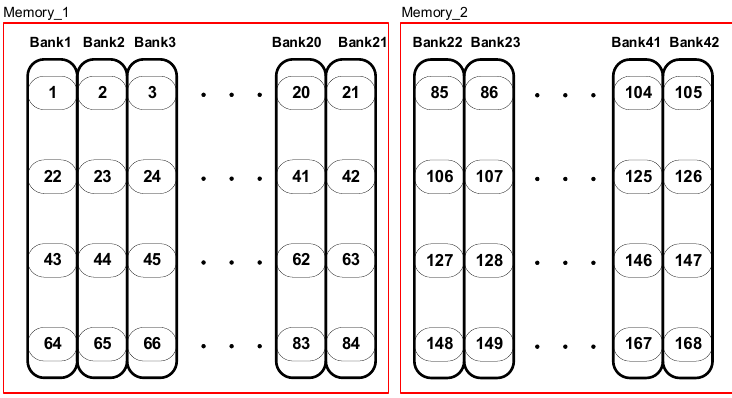
Figure 32. Extrinsic memory in reconfigurable multi-standard decoder.